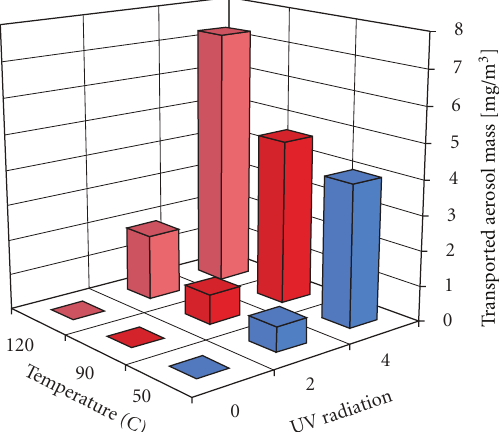
Figure 7: Particle mass concentration in CH 3 I experiments as a function of radiation intensity and